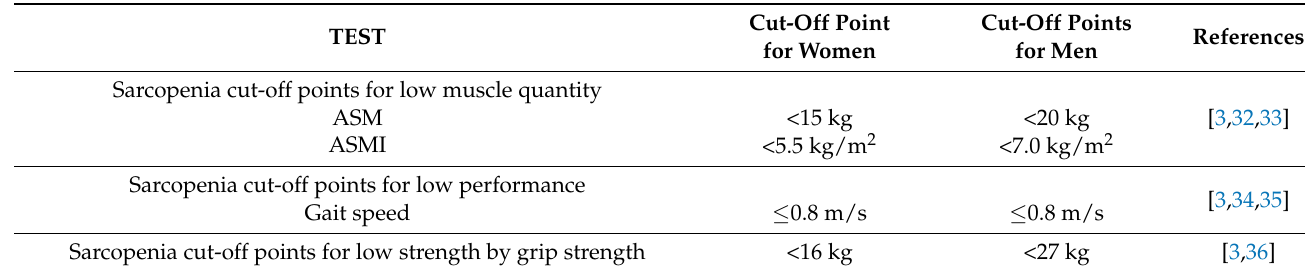
Table 1. Sarcopenia cut-off